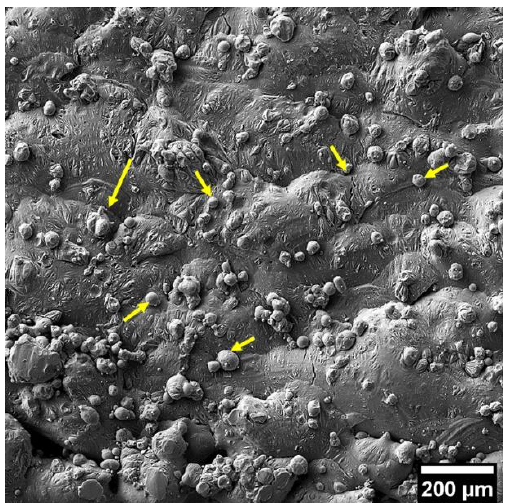
Figure 5. Appearance of surface of 3D-printed RS-333 alloy with the indicated (yellow arrows) surface features.